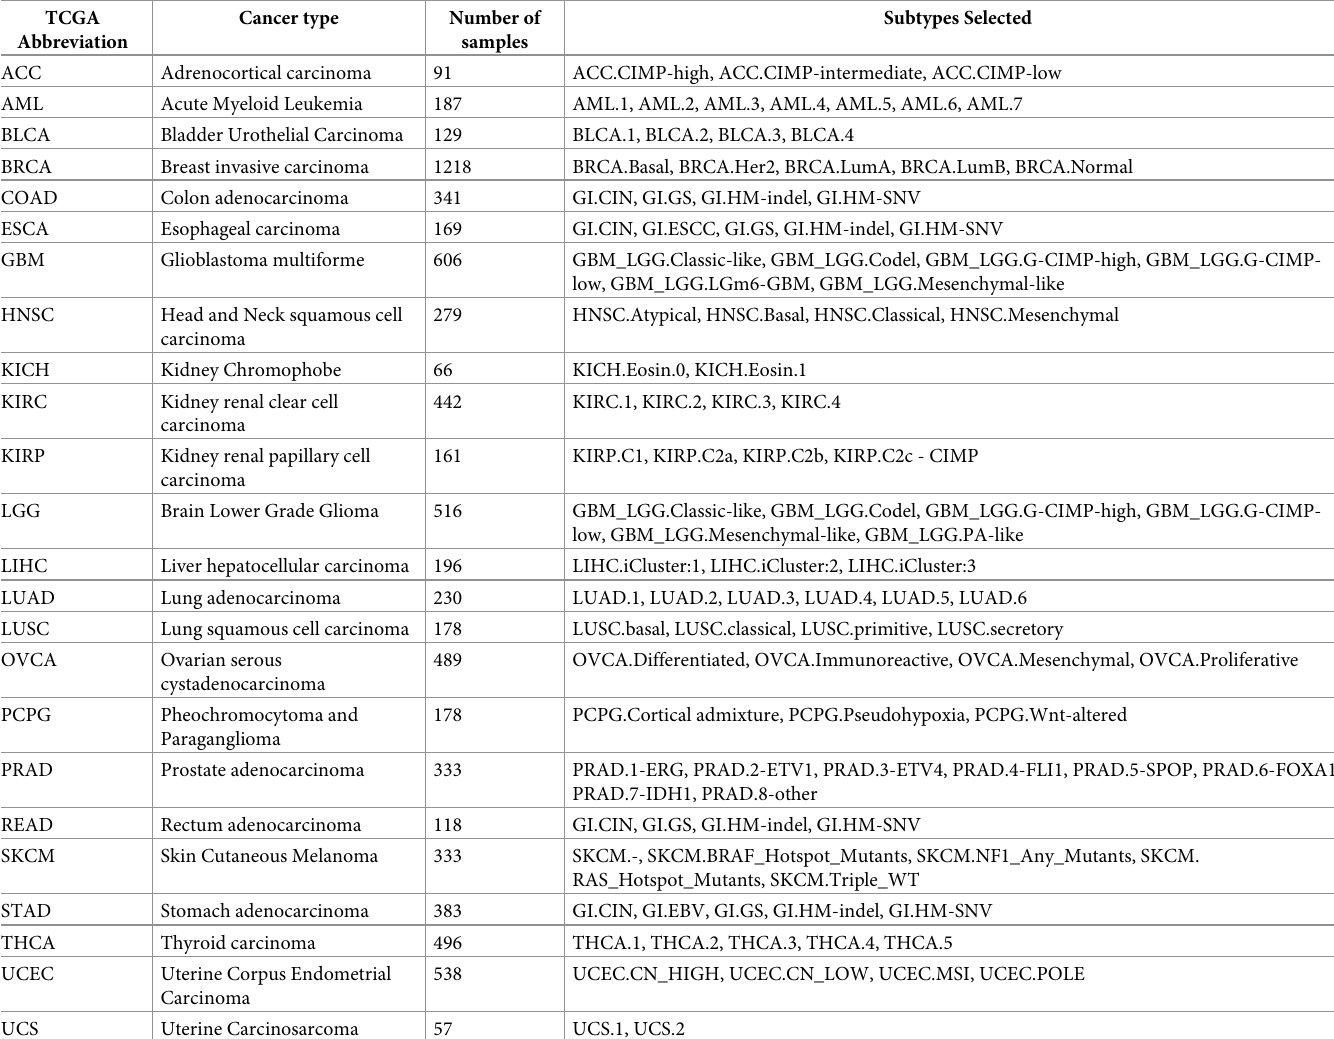
Table 1. Information on molecular subtypes for TCGA cancer studies as provided by the TCGA_MolecularSubtype function. TCGA